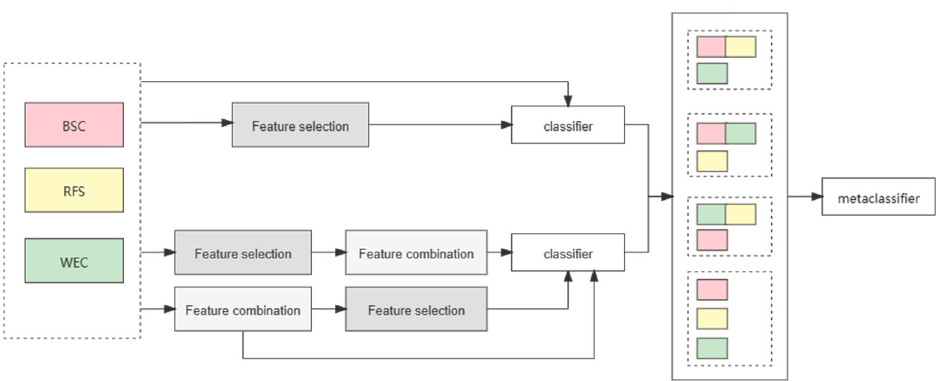
Figure 1. Suicide ideation detection framework. Note: BSC = basic statistical characteristics, RFS = risk factors for suicide, WEC = word embedding clustering.